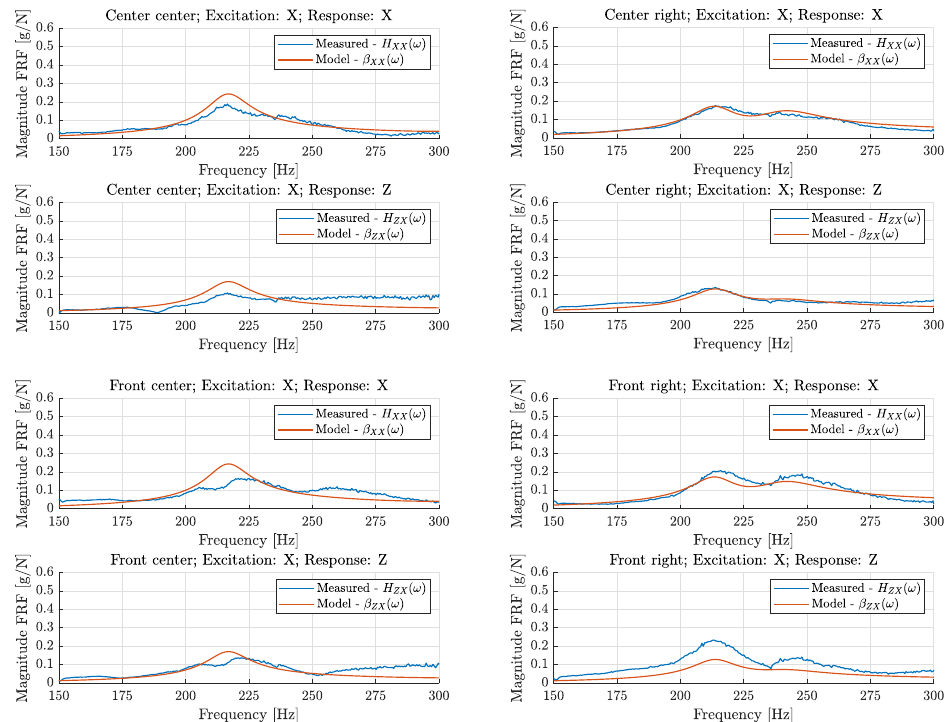
Figure 16. Comparison between the measured FRFs and the numerical FRFs in different positions of the working table.